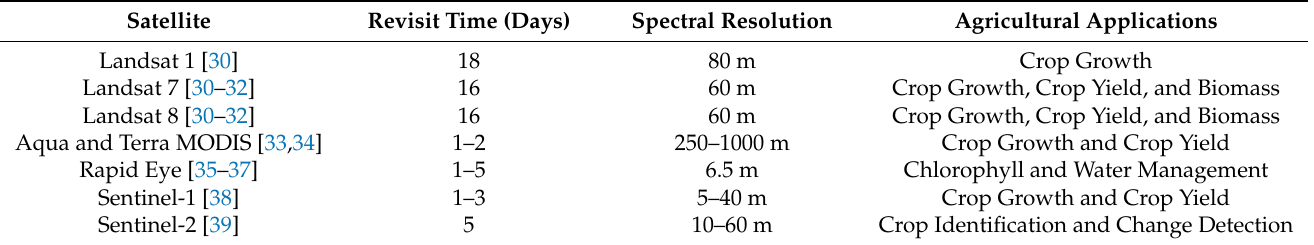
Table 1. Commonly used satellite platforms in agricultural applications along with their